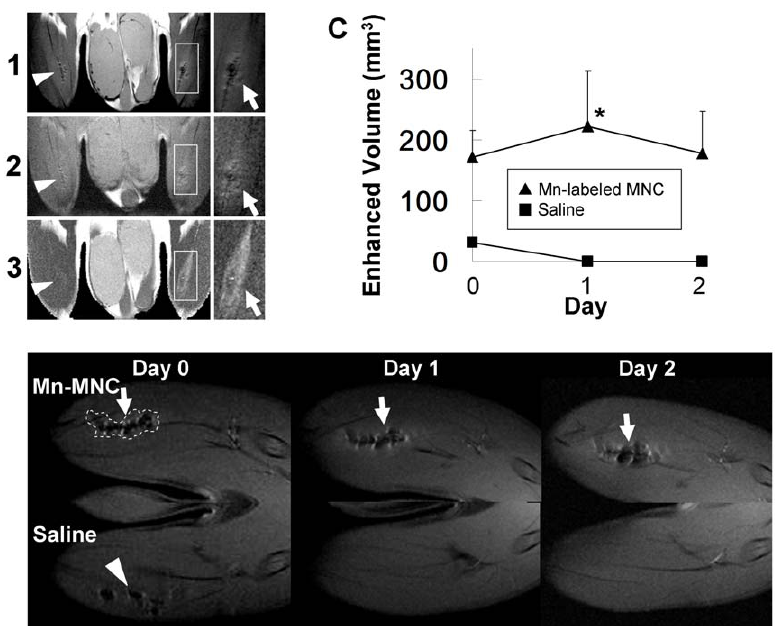
Figure 2. Typical MR images immediately after transplantation of Mn-labeled MNCs and short-term changes of the signal intensity in ischemic rat legs. A typical horizontal T 1 -weighted image (A1), proton density image (A2), and calculated T 2 map (A3) are presented for the same animal immediately after the injection of Mn-labeled MNCs. The images on the right are magnifications of the area inside the white rectangles. Mn- labeled MNCs (white arrows) were injected into the left leg (right side of the images) and saline (white arrow heads) was injected into the right leg (left side of the images). (B) Short-term observation of T 1 -weighted signal enhancement in ischemic rat legs is presented. The upper figures show horizontal T 1 -weighted MRI after Mn-labeled MNC injection from 0 to 2 days after the transplantation. The lower figures show T 1 -weighted MRI after saline injection in the same animal (contralateral leg). The area enclosed by the white dotted lines is an example of a typical region of interest (ROI). At both 1 and 2 days after injection, Mn-labeled MNCs were visualized as a ‘‘double-layered structure’’ that has a positive outline and dark core (B, white arrows). The signal reduction after saline injection soon disappeared (B, white arrow head). (C) Volume change after the MNC injection. The filled triangles indicate volume change at the Mn-labeled MNC injected site and the filled squares correspond to the saline injected site. * Significant difference vs. volume of saline injected control, level of significance P , 0.05 for two-way ANOVA with Bonferroni post-hoc test (n=3).